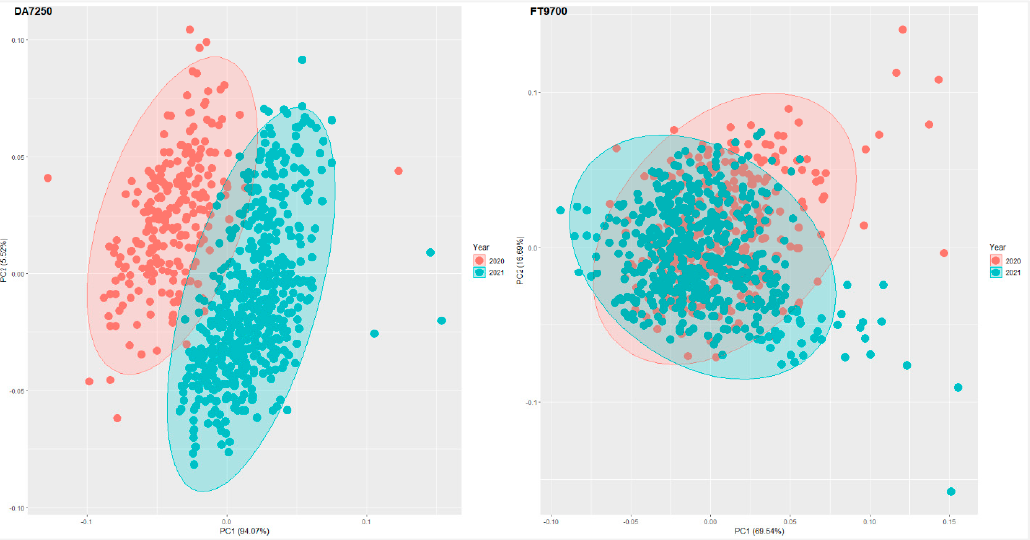
Figure 2. Clustering of pea samples based on the first and second principal components generated using DA7250 and FT9700 spectral data. Table 3. Mean and variability in protein concentration by growing seasons and